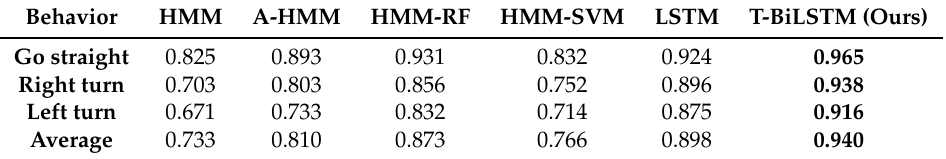
Table 7. The results of vehicle trajectory classification for behavior recognition. We show the accuracy on each type and the average value (higher is better). The best values are highlighted using a bold